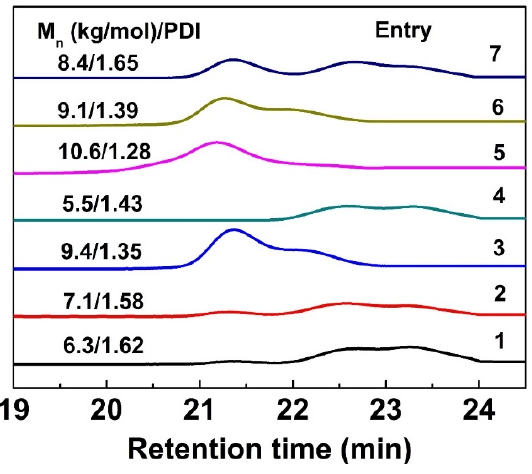
Figure 1. SEC traces of PEGylated PA/AGE copolymers in Table 1.